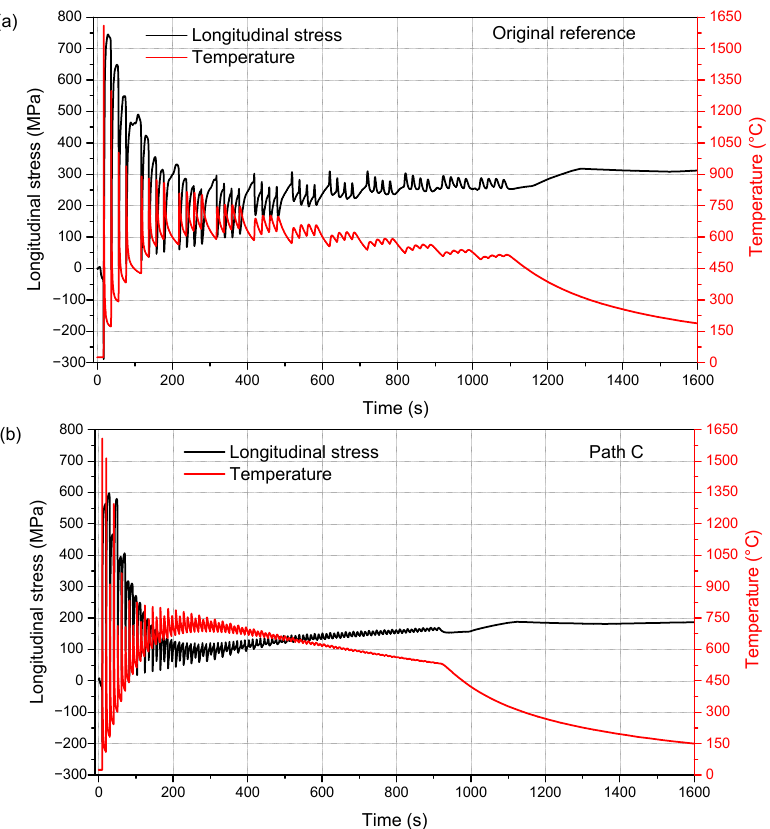
Figure 15. Comparison between the temperature and longitudinal stress ( σ xx ) of point Q (see Figure 3): ( a ) original reference; ( b ) path C.